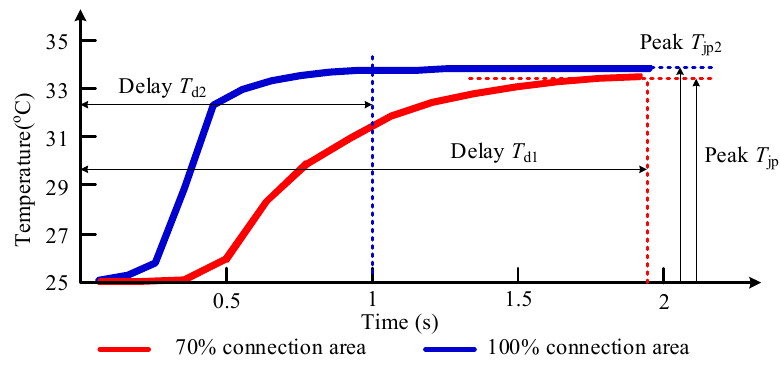
Figure 10. Comparison of T j response curves with varying thermal grease area.